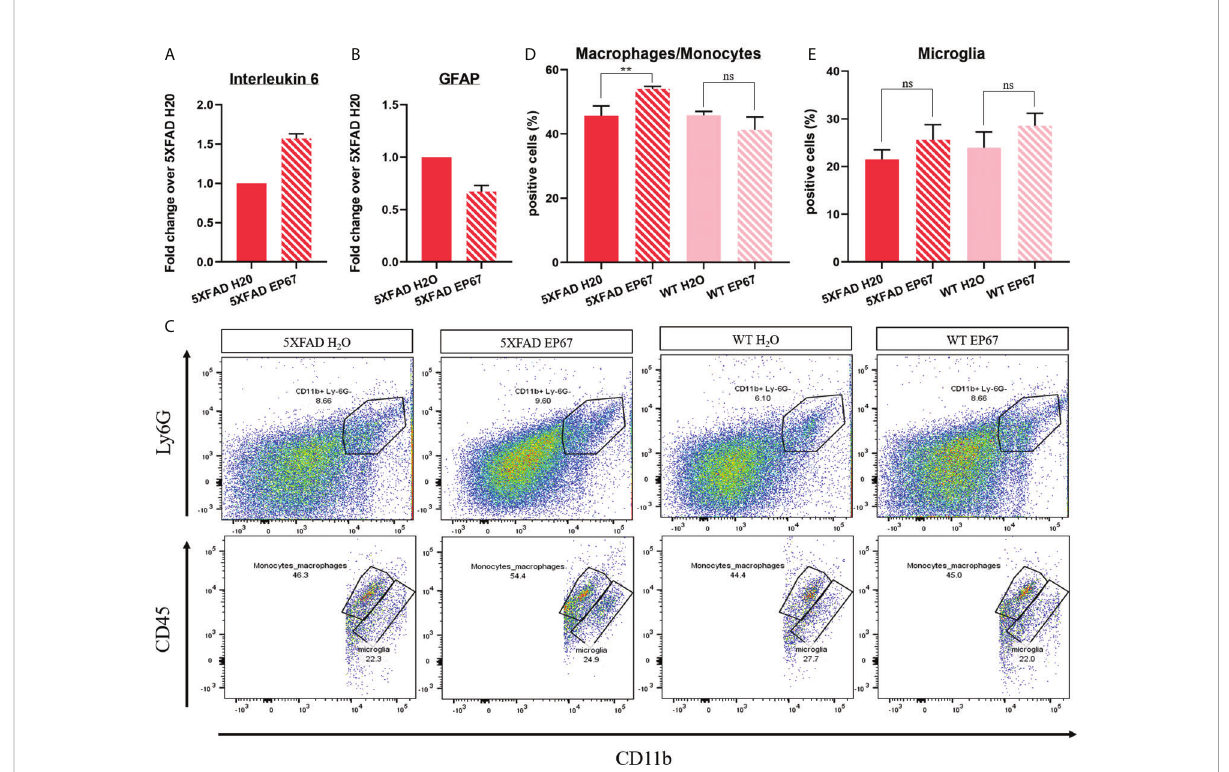
FIGURE 2 Peripheral in fi ltrating macrophages assist in amyloid catabolism. (A, B) RT-qPCR in 5XFAD- and 5XFAD EP67-treated animals ( n = 3 both groups, mean ± SEM); transcript levels represent average fold change of treated animals over their controls. Interleukin-6 expression was found to be increased (A) , while GFAP expression was decreased (B) . (C – E) Representative gating exemplifying separation between peripheral macrophages/ monocytes (CD45 high /CD11b + ) and resident microglia (C45 int /CD11b + ) (C) and respective quanti fi cation indicating an increased amount of macrophages/microglia (D) in the brain and an unchanged amount of resident microglia (E) . n = 4 both groups, mean ± SD. **P value ≤ 0.01; ns, Not Signi fi